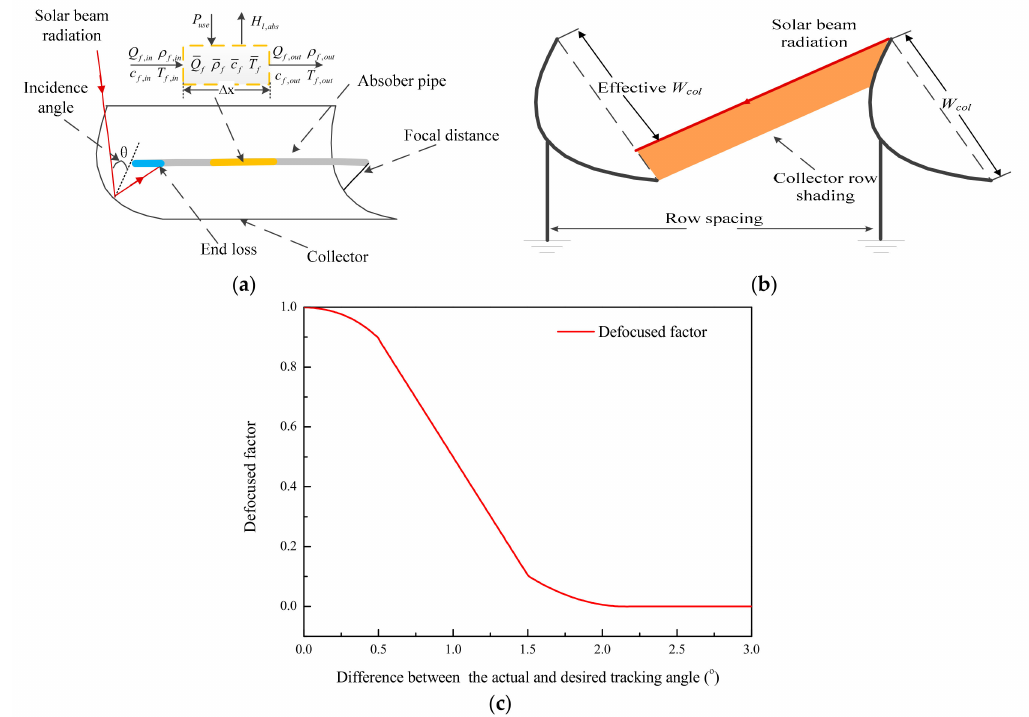
Figure 3. Thermal and optical analysis of the parabolic trough collectors (PTC) for ( a ) control volume and end loss; ( b ) row shading; and ( c ) trend of the defocused